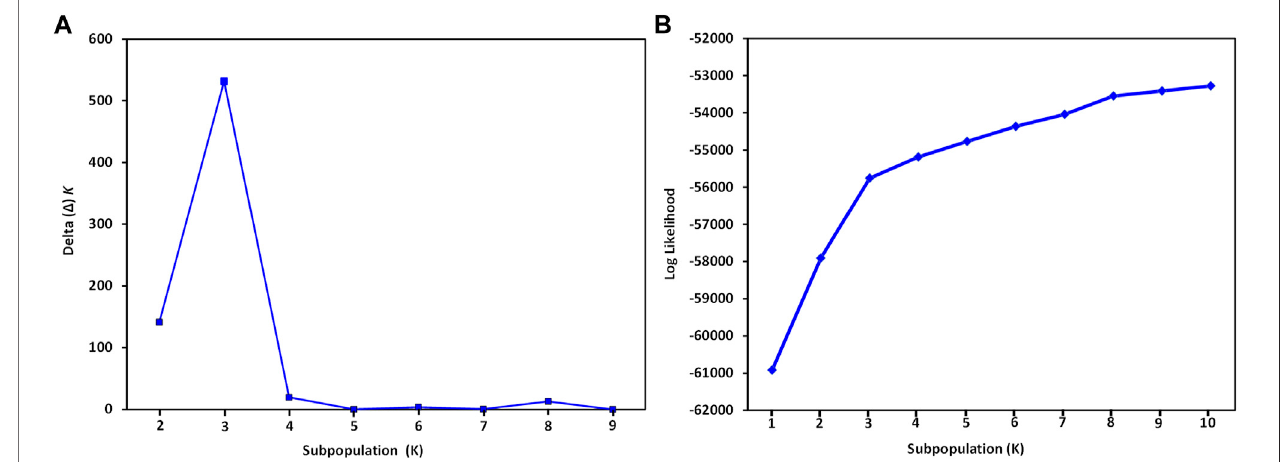
FIGURE 2 | Graphical representation of variance in the number of subpopulations, K, and mean likelihood values generated with the software STRUCTURE for 16 Spinacia oleracea and 76 S. turkestanica accessions based on 7,065 single nucleotide polymorphisms common to these accessions. (A) Delta ( Δ ) K for the different number of spinach subpopulations (K). (B) The average log likelihood values of K.